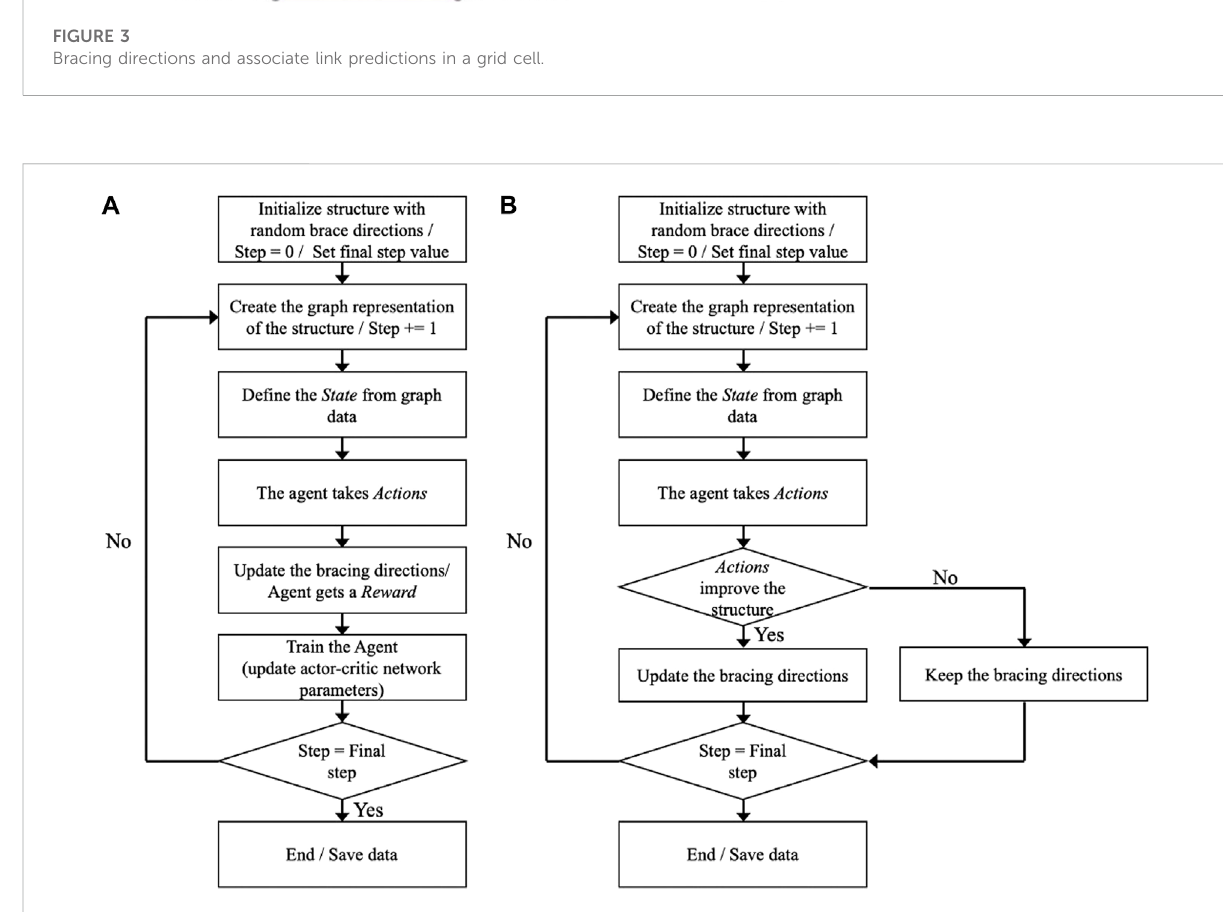
FIGURE 4 Algorithms of the proposed method; (A) Training phase, (B) Test